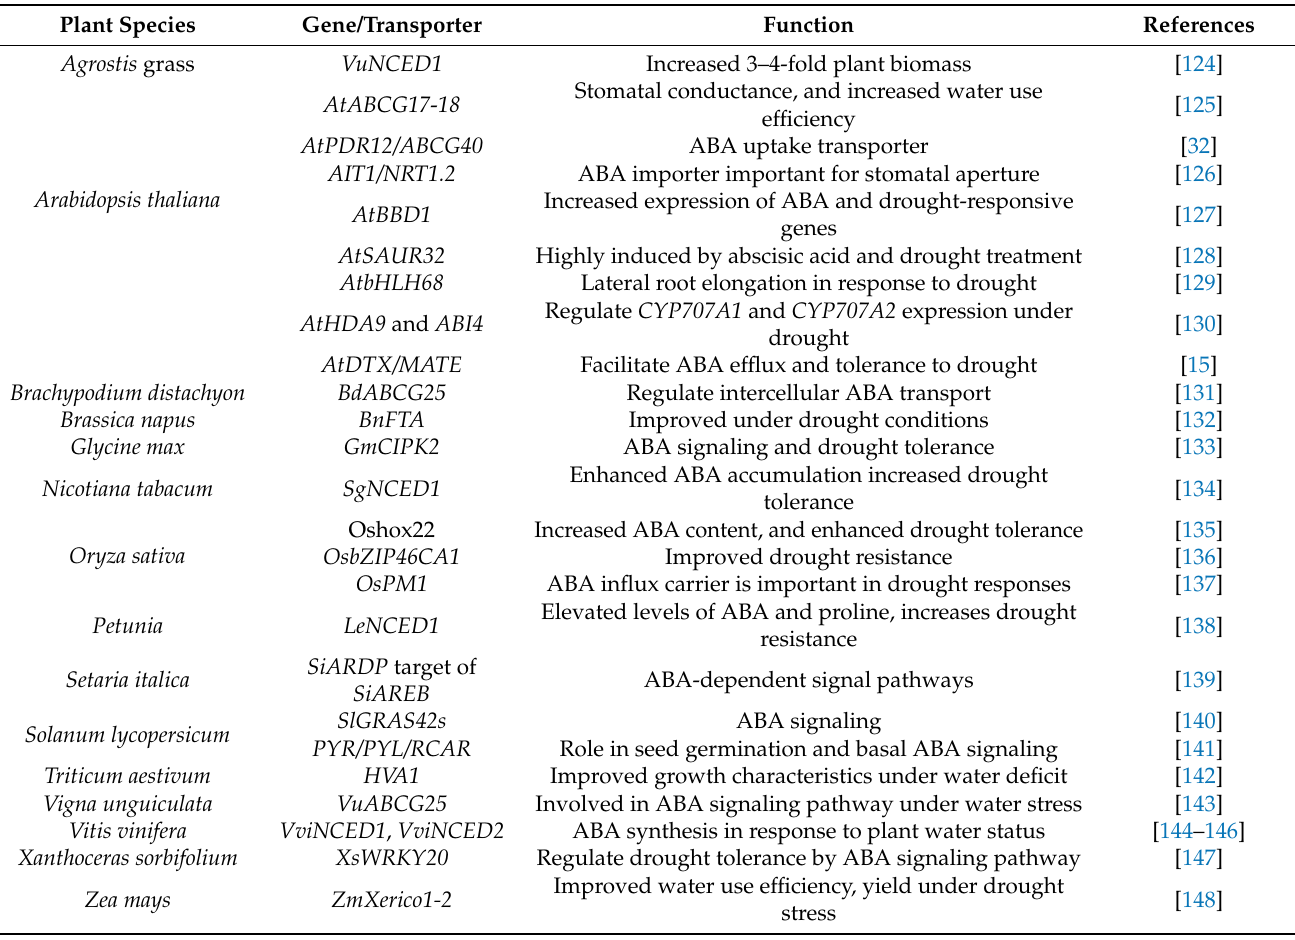
Table 1. Some important genes or transporters for improved drought tolerance through modulating ABA signaling pathway in